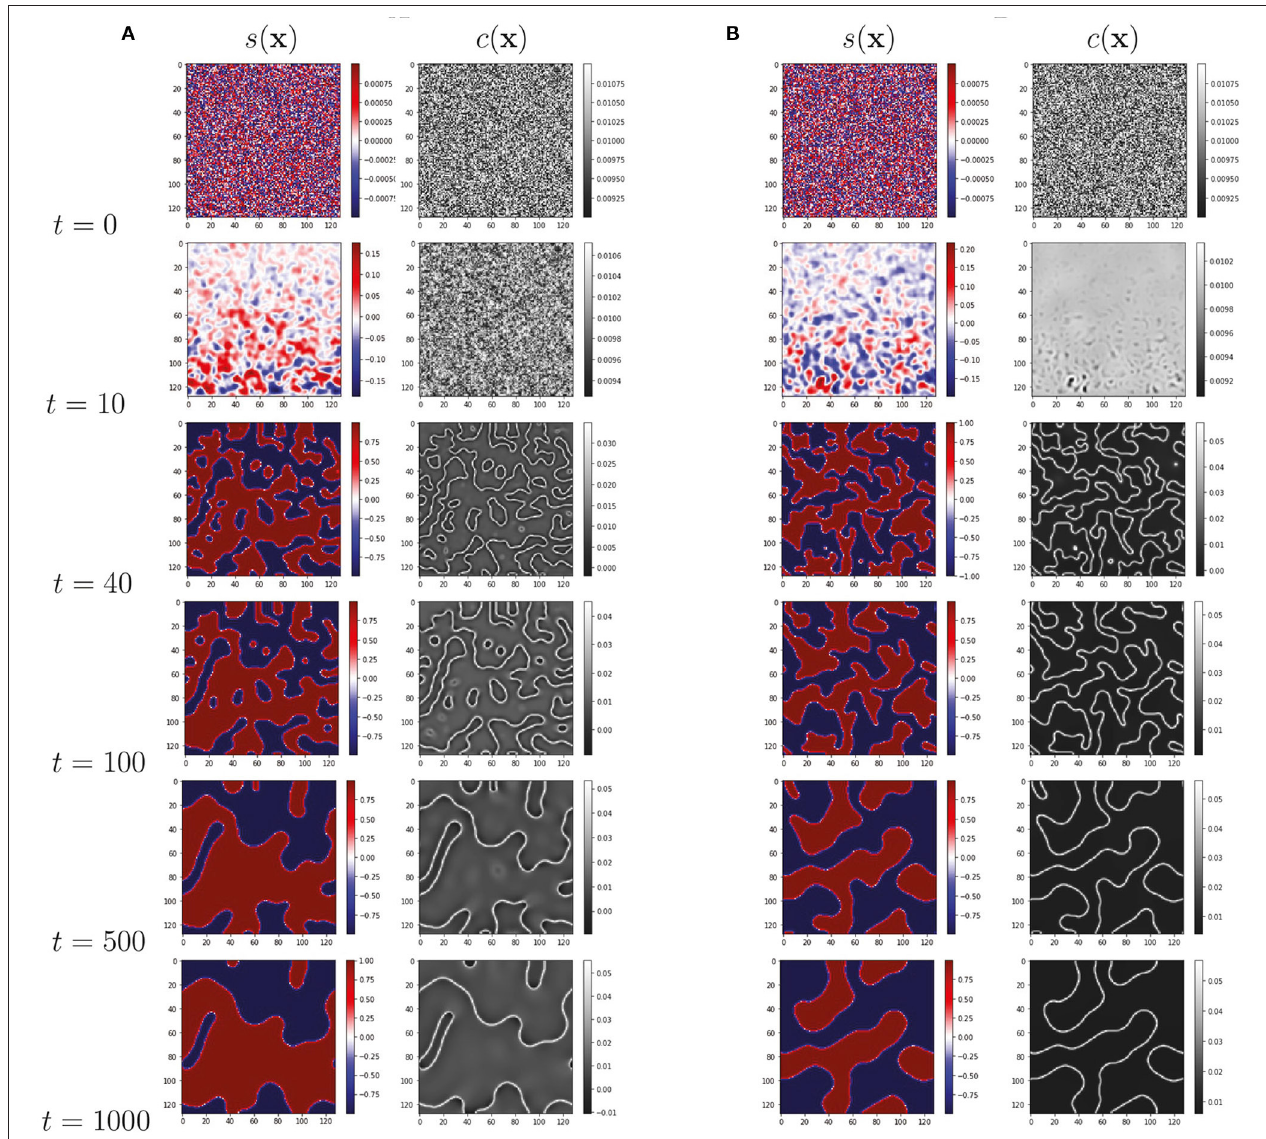
FIGURE 1 | Time evolution of nematization s ( x ) and NP concentration c ( x ), from the scalar model (9): (A) for NP mobility R segregates to the domain walls where the nematization is diminished with respect to the interior of the nematic domains. This segregation is more pronounced for the more mobile case (B) . Parameters g but, once the NPs segregate, we expect that at long times s